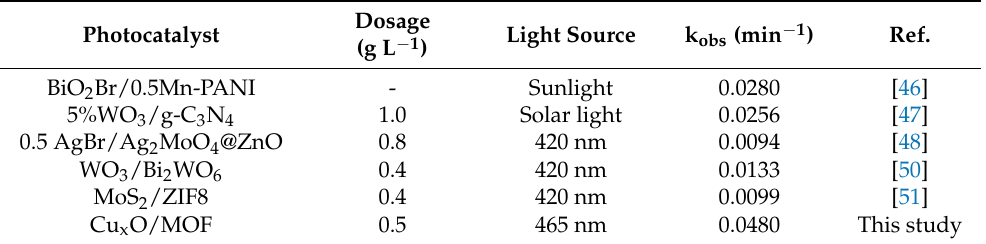
Figure 5. ( a ) The overall removal efficiency and ( b ) rate constants for the CIP photodegradation over 0.5 g L − 1 Cu x O/MOF as a function of the initial CIP concentrations at 10–40 mg L − 1 , ( c ) adsorption isotherm of CIP with the fitted Langmuir, Sips, Toth, and Redlich-Peterson model, and ( d ) recyclability of Cu x O/MOF towards the CIP decomposition under visible light irradiation. Table 1. Comparison of the CIP photodegradation kinetic over Cu x O-MOF with other reported visible-light-driven